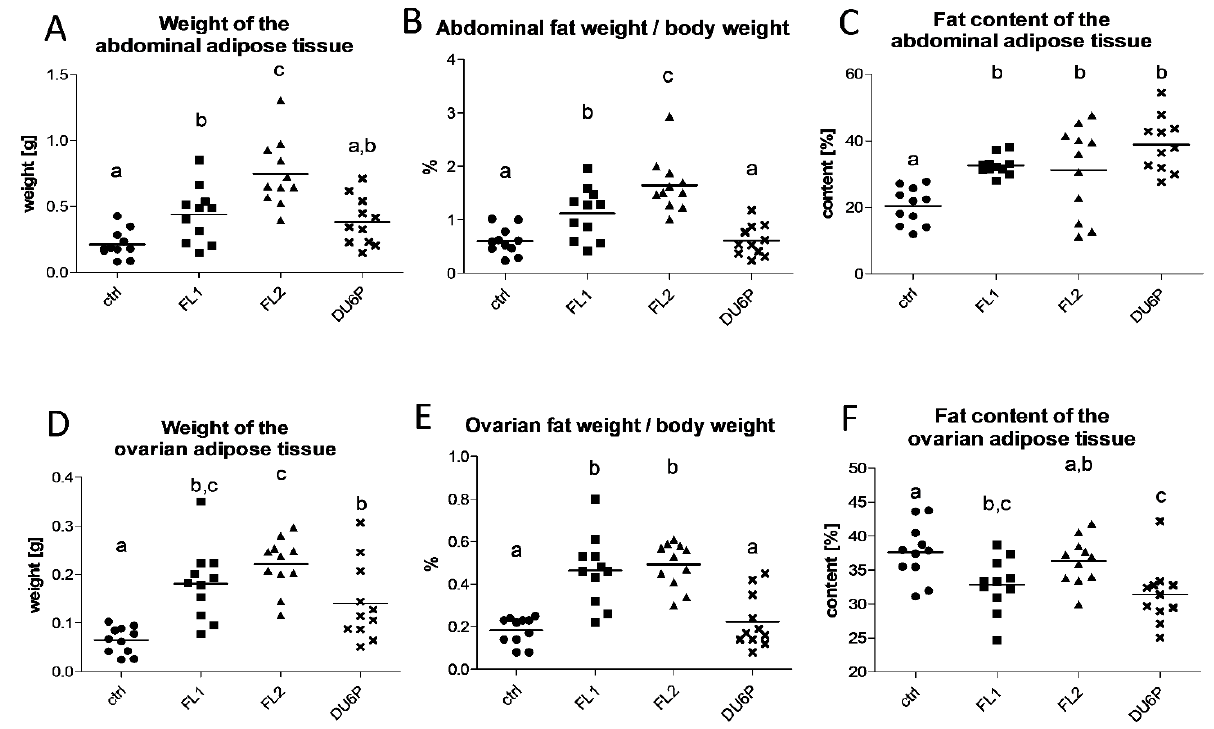
Figure 2. Weight of the adipose tissue coming from abdomen ( A ) and around the ovaries ( D ), weight of the adipose tissue, with respect to the body weight, in the abdomen ( B ) and ovaries ( E ) in control (circles), FL1 (squares), FL2 (triangles) and DU6P (crosses) lines. Fat content/lipid portion of the adipose tissue of the abdomen ( C ) and around the ovaries ( F ) in the same lines. Data are illustrated as the mean ± SEM (standard error of the mean) and designated significant if p < 0.05 (Tukey posttest: different letters correspond to different levels of significance).